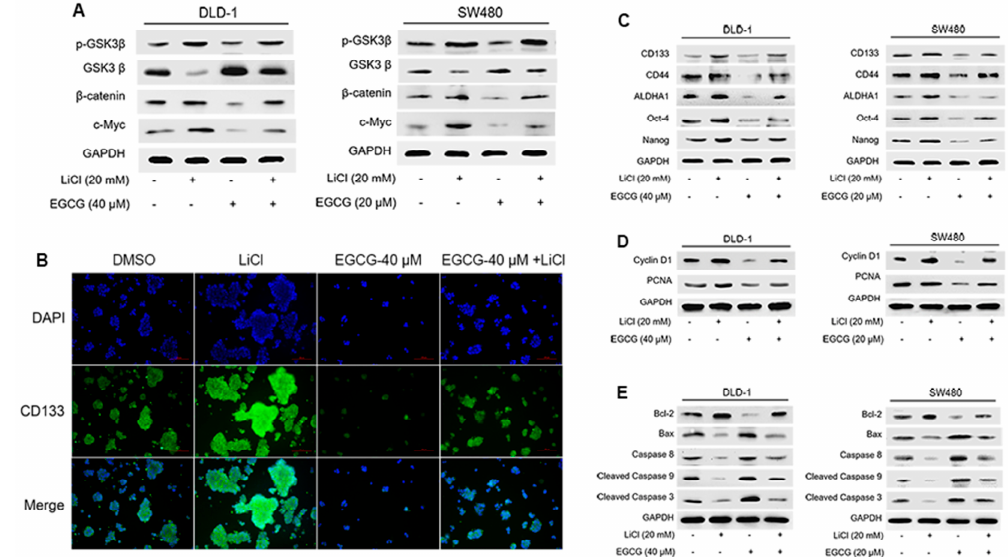
Figure 5. EGCG diminished colorectal CSCs through suppression of Wnt/ β -catenin pathway. DLD-1 and SW480 spheroids were treated with different concentrations of EGCG and LiCl for six days. ( A ) Western blot analysis was applied to measure the protein levels of Wnt/ β -catenin pathway; ( B ) Immunofluorescence staining images of spheroids were obtained to determine the expression of CD133. ( C – E ) Western blot analysis was used to measure the protein levels of CSC markers ( C ), proliferation-related proteins ( D ), and apoptosis-related proteins ( E ).